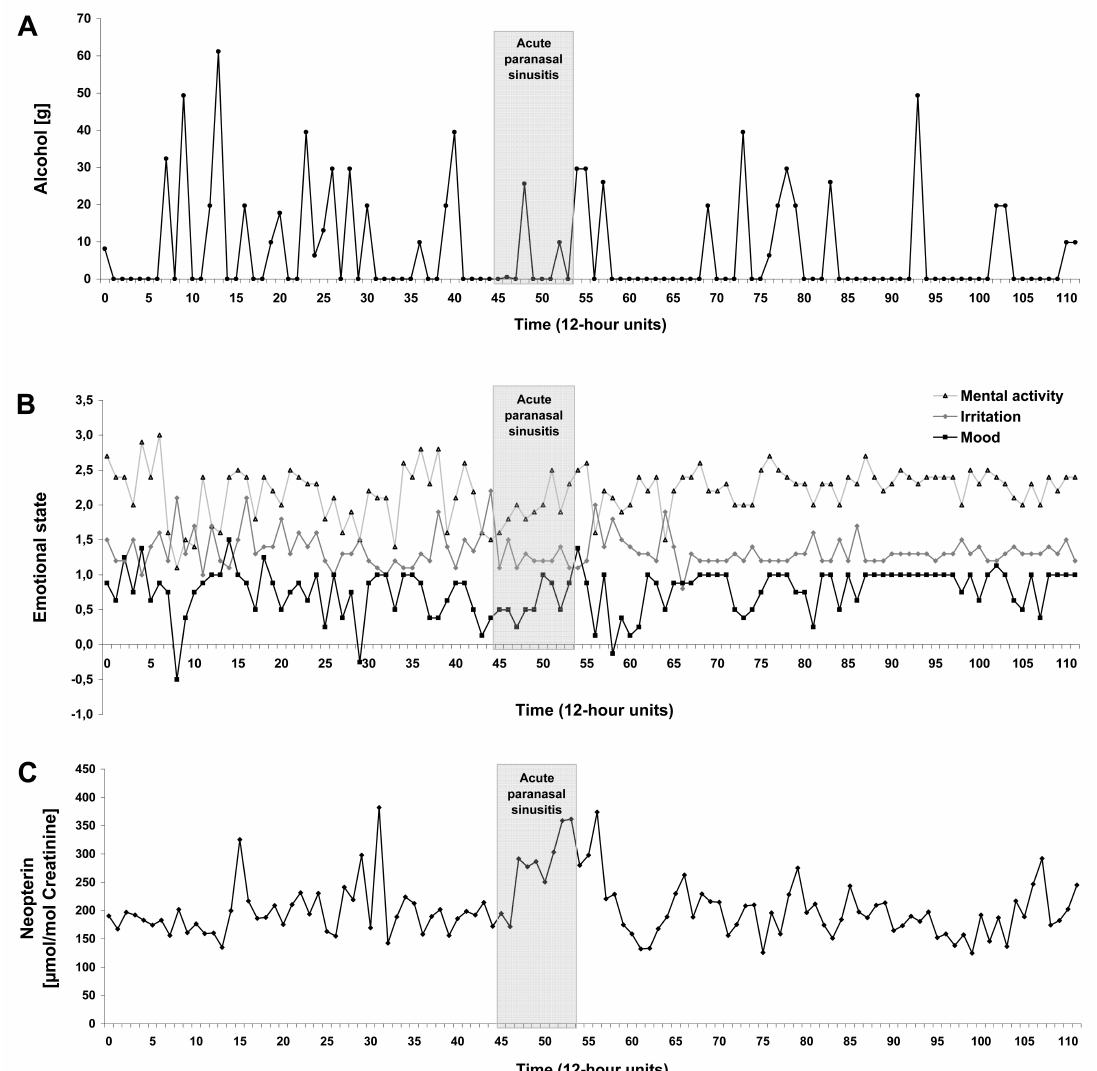
Figure 1: Findings from adjusted cross-correlational analyses between alcohol intake and the emotional state variables under study (mental activity, irritation, mood) as well as between urinary neopterin levels and emotional states. Various observational periods were analyzed: 12-hour units 1–122 (A), 1–44 (B), and 55–112 (C). A pos- itive lag indicates that the first series (i.e., alcohol, neopterin) leads the second series (i.e., mental activity, irrita- tion, mood), whereas a negative lag means that an opposite direction of effect exists, i.e., that the first series fol- lows the